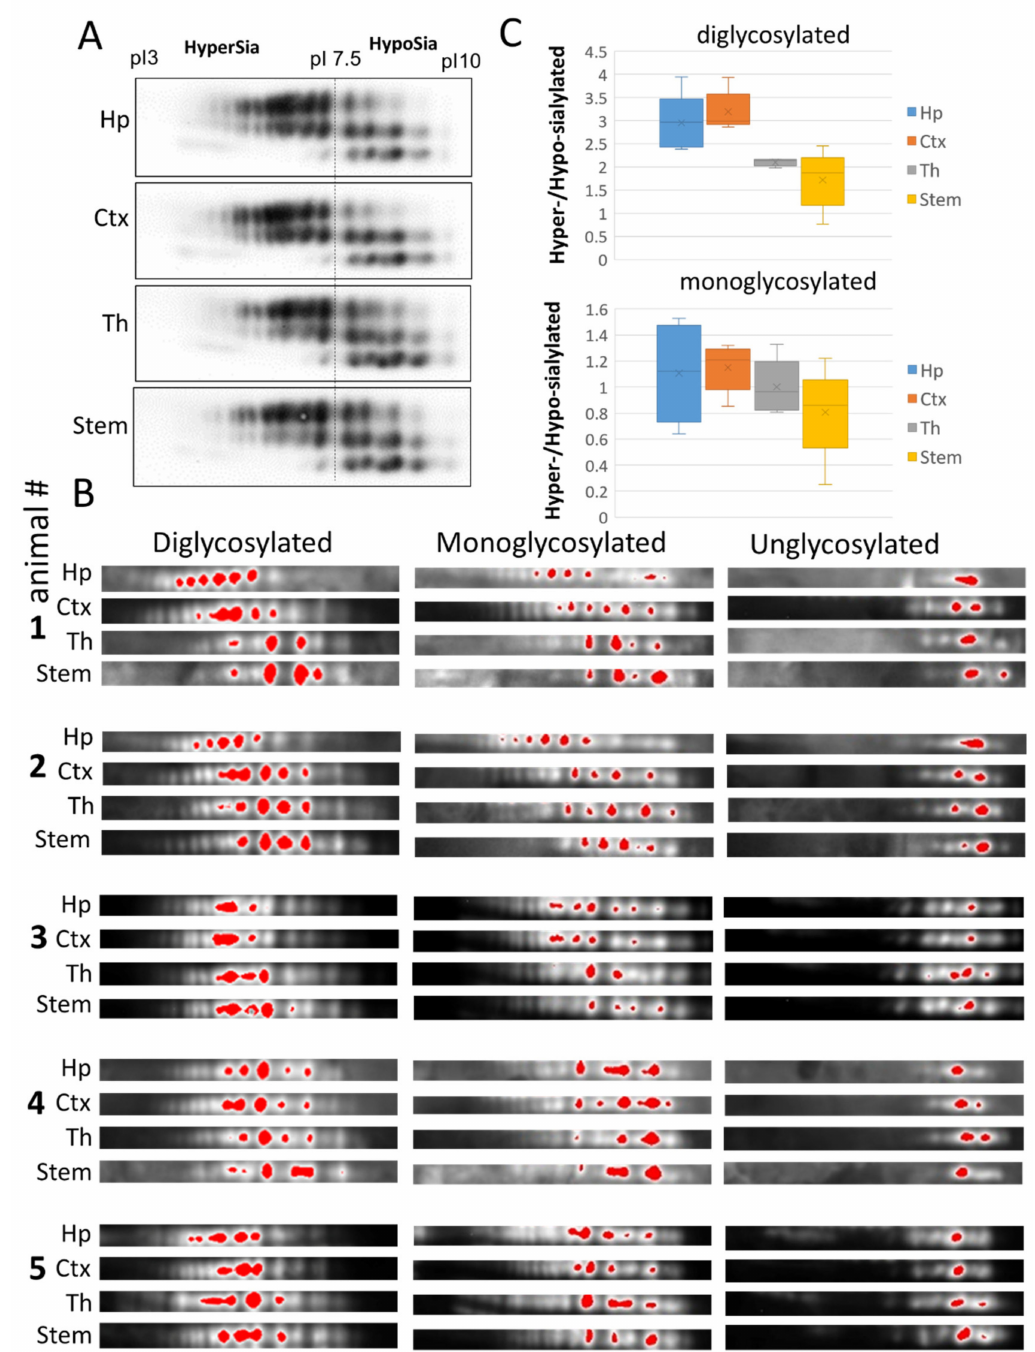
Figure 3. Analysis of sialylation status of PrP Sc from four brain regions of 22L-infected animals. ( A ) Representative 2D Western blot of PrP Sc from hippocampus (Hp), cortex (Ctx), thalamus (Th) and stem of 22L-infected animals. Prior to 2D blot, brain materials were treated with 20 µ g / mL PK. ( B ) 2D Western blots of PrP Sc from hippocampus (Hp), cortex (Ctx), thalamus (Th) and stem grouped according to PrP glycosylation status (di-, mono- and unglycosylated, n = 5 animals). Prior to 2D blot, brain materials were treated with with 20 µ g / mL PK. Intensity of individual sialoglycoforms is visualized by red color using Alpha View software. ( C ) A box and whisker plot showing the ratio of hypersialylated versus hyposialylated PrP Sc in hippocampus (Hp), cortex (Ctx), thalamus (Th) and stem. Diglycosylated and monoglycosylated sialoglycoforms are analyzed separately. The mean (x), the minimal and maximal values (the vertical line), and the medians of the bottom and the top half (the bottom and top lines of the box, respectively) are shown ( n = 5 animals). The ratio of hypersialylated versus hyposialylated isoforms is calculated as described in Materials and